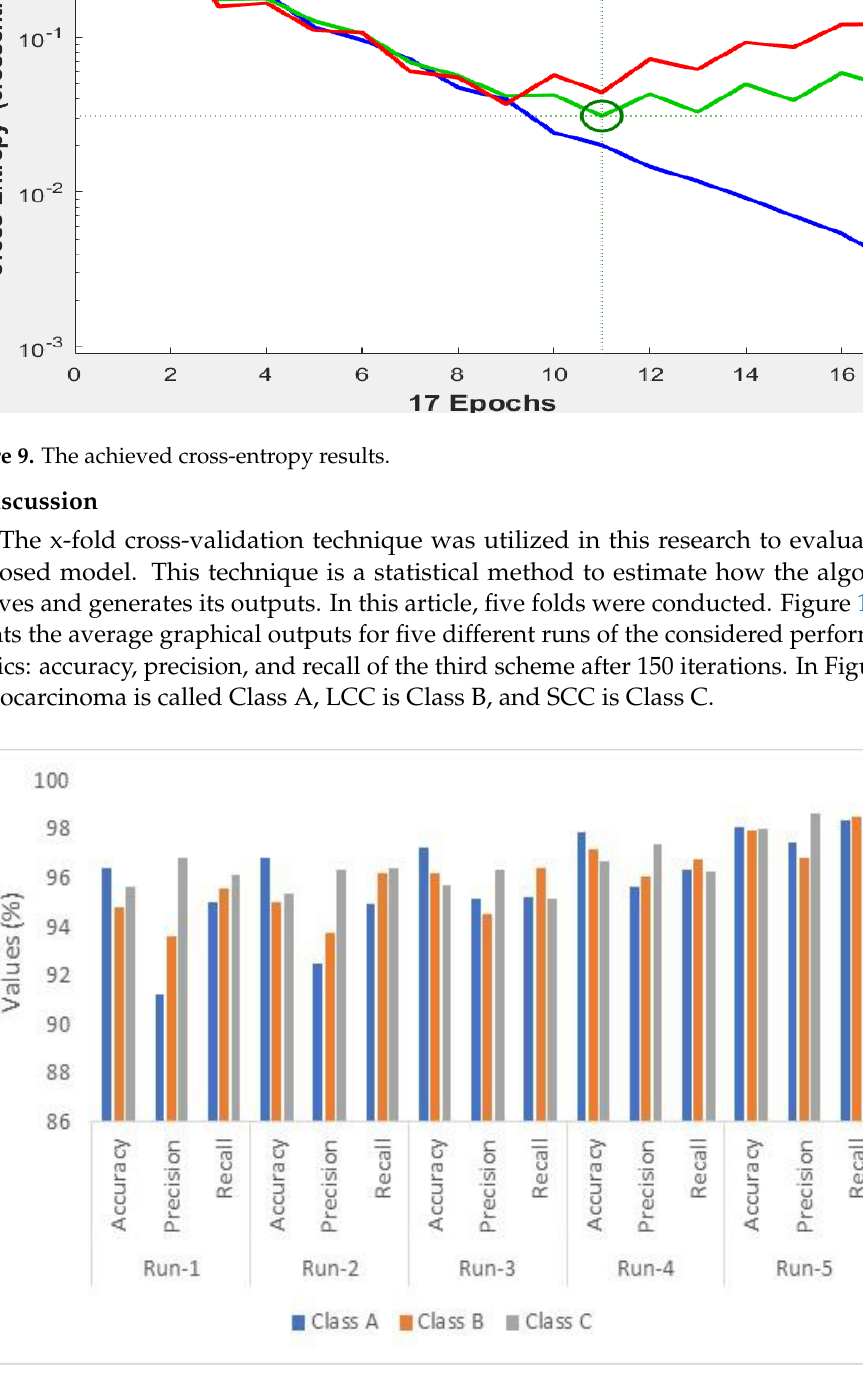
Figure 10. Result analysis of the proposed model.